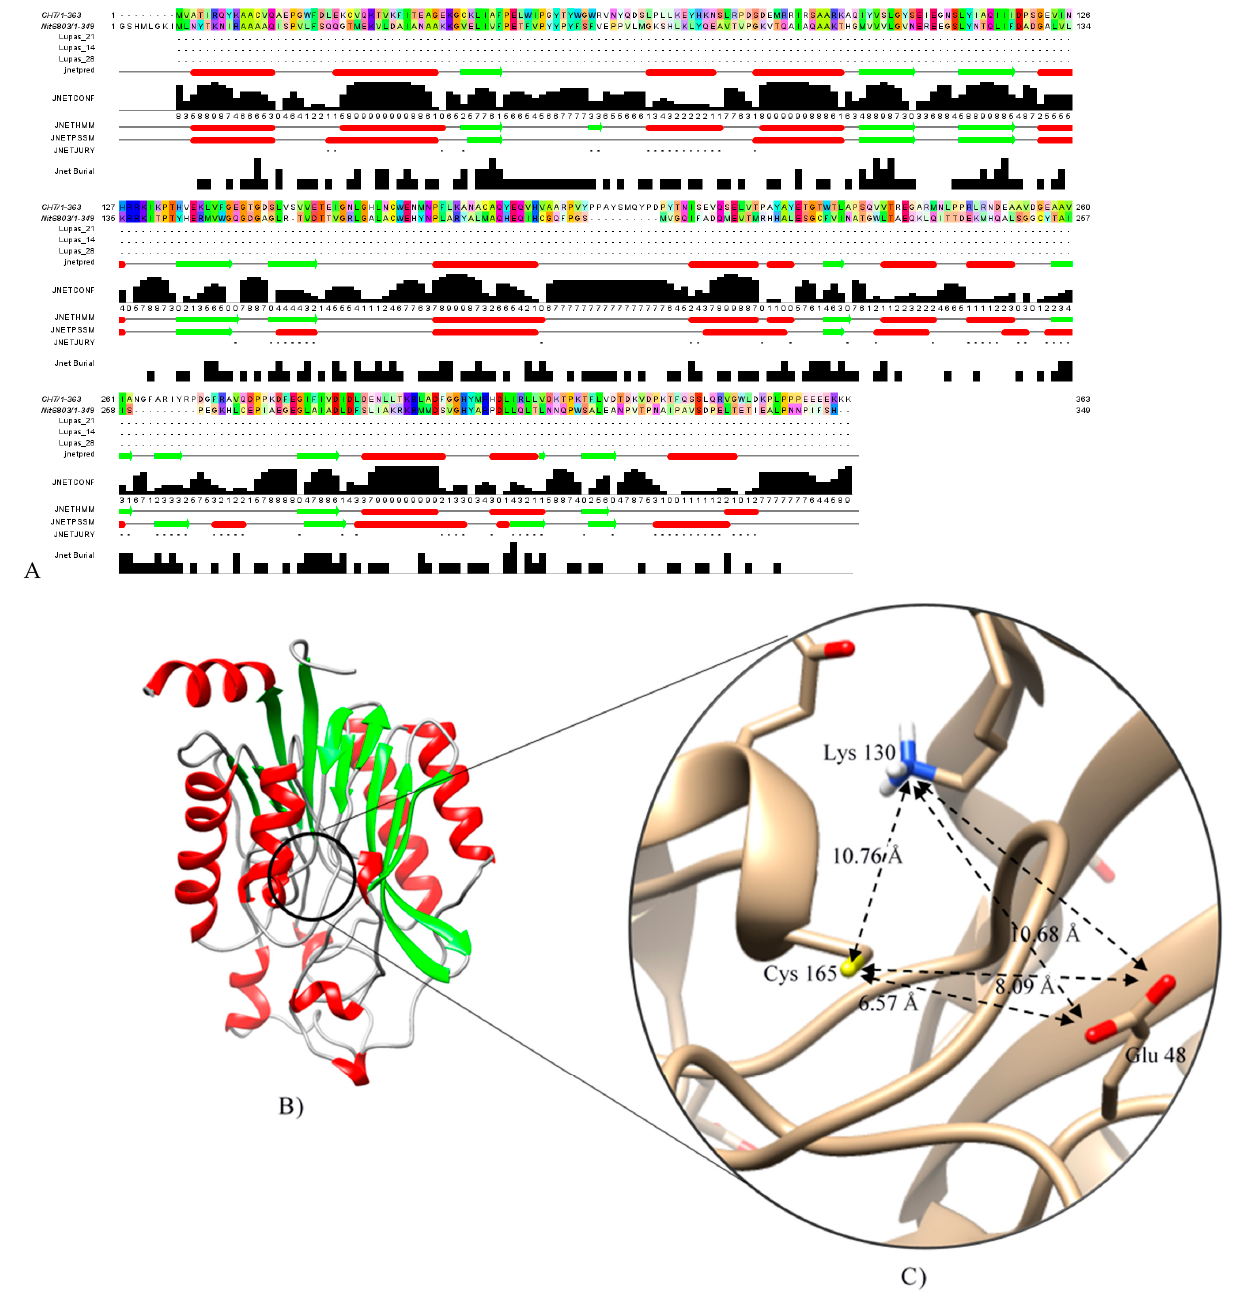
Figure 4. ( A ) CHT and Nit6803 and alignment of their secondary structural elements. ( B ) Tertiary structure of cyanide hydratase model, and ( C ) its catalytic triad predicted by Chimera software [24].